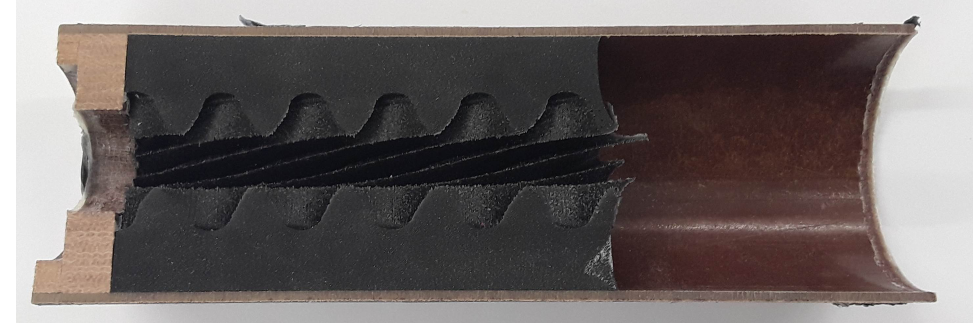
Figure 8. Sectional view of a test fuel block after the mold was dissolved.